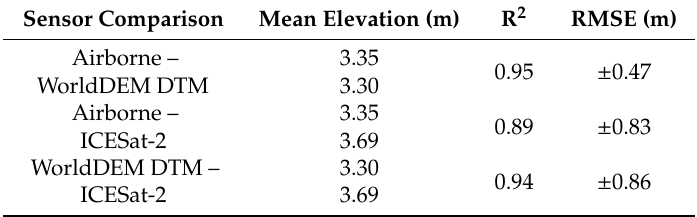
Table 1. Comparison of measured elevation from di ff erent tested sensors (N points = 13.129).